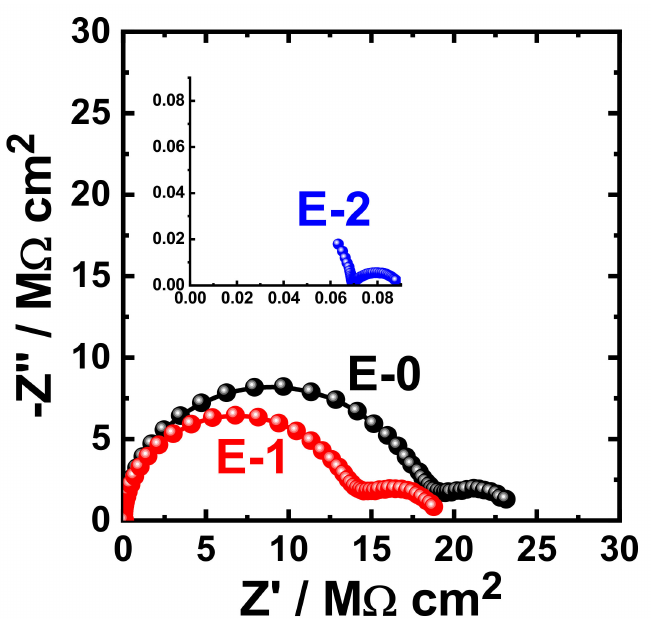
Figure 12. Typical Nyquist plots obtained for E-0, E-1, and E-2 after their immersion in 3.5% NaCl solutions for 21 days.